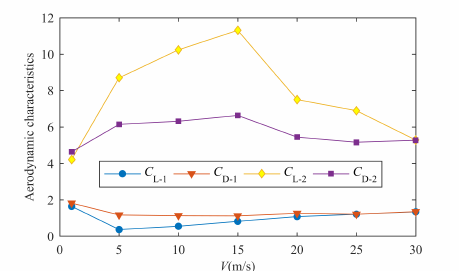
Fig. 7. Variation of aerodynamic coefficient of positive feeder with wind